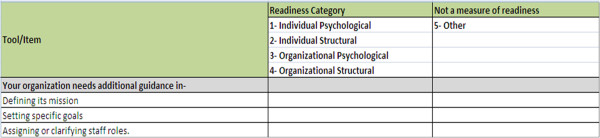
Mapping worksheet.